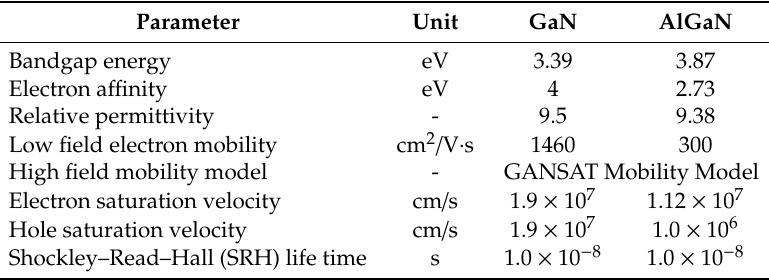
Table 2. Material properties used for